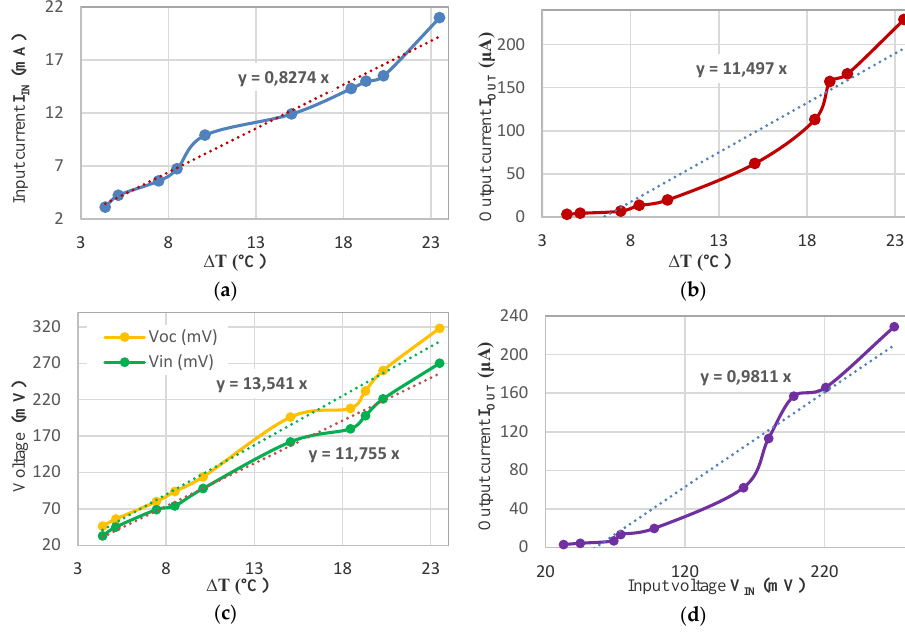
Figure 16. TMG-127-1.4-1.2 TEGs characterization: input current I IN ( a ), output current I OUT ( b ), open-circuit V OC and input V IN voltages ( c ) as function of ΔT, and output current I OUT as function of the input voltage V IN ( d ).